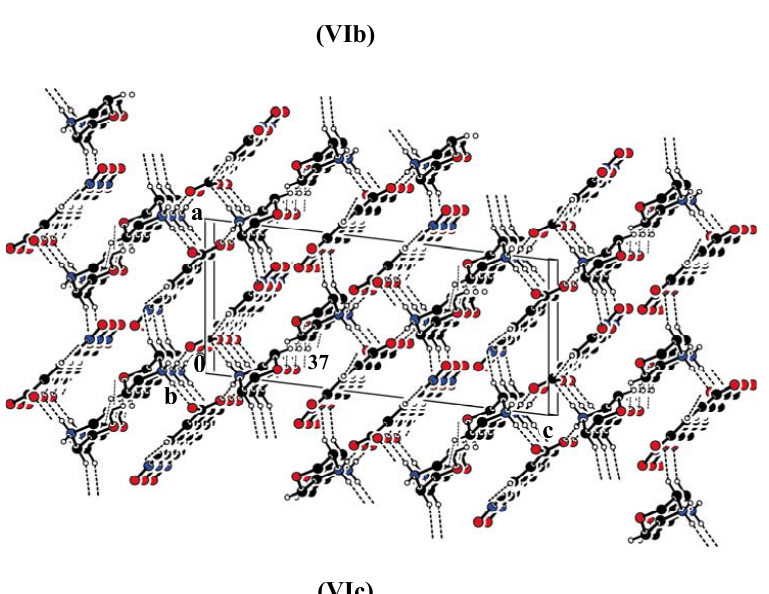
(12) are connected by 4